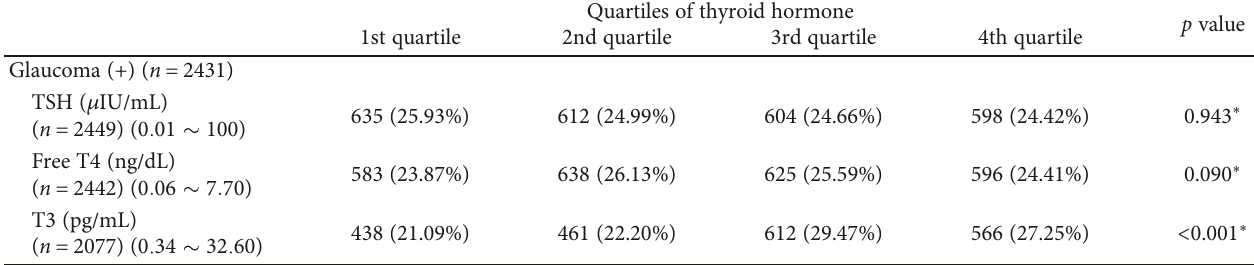
Table 2: Univariate analysis of glaucoma and thyroid function.